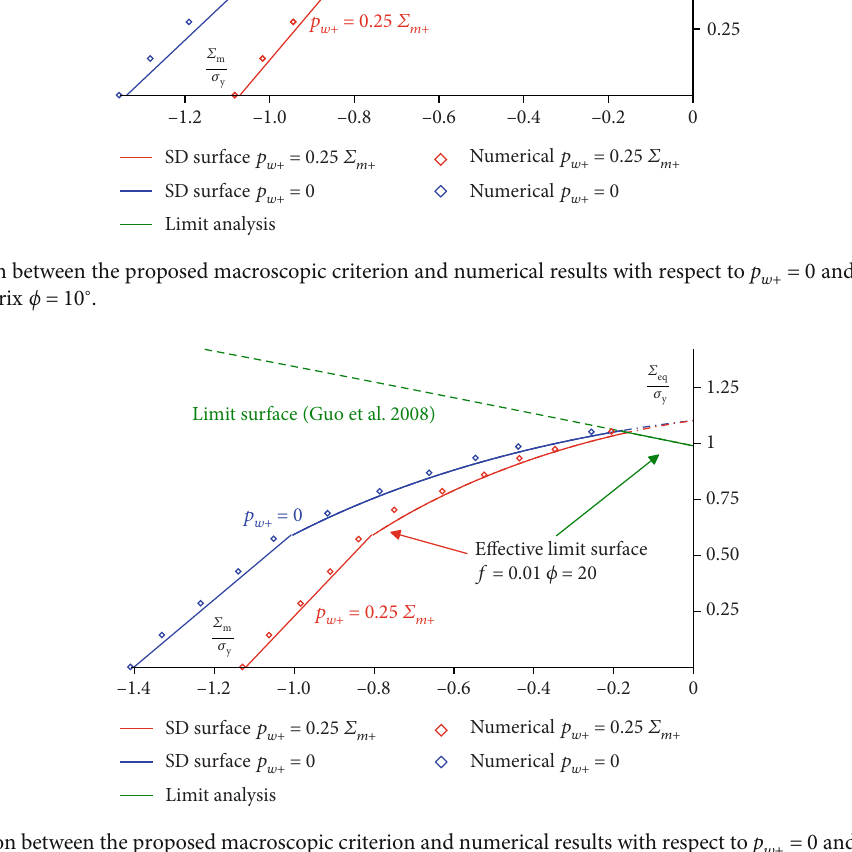
Figure 10: Comparison between the proposed macroscopic criterion and numerical results with respect to p angle of the solid matrix ϕ = 20 °